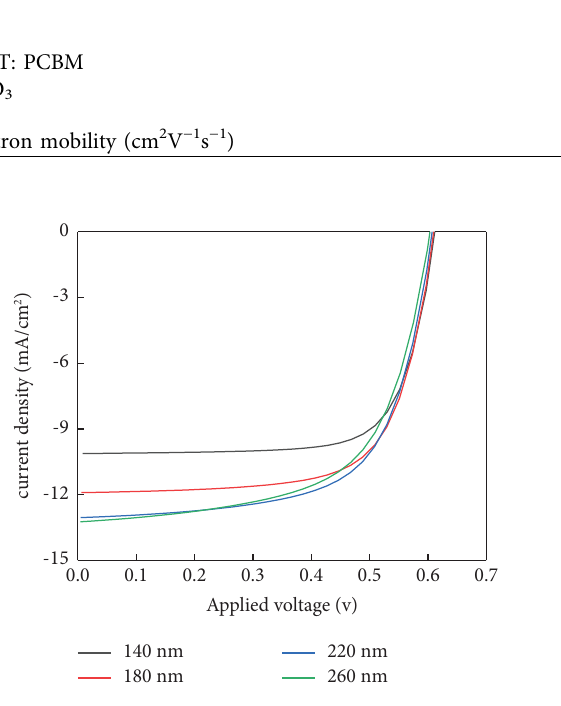
Figure 2: Current density vs applied voltage for various active layer thicknesses. Table 2: Evaluated parameters of the cells for various thickness of active layer.